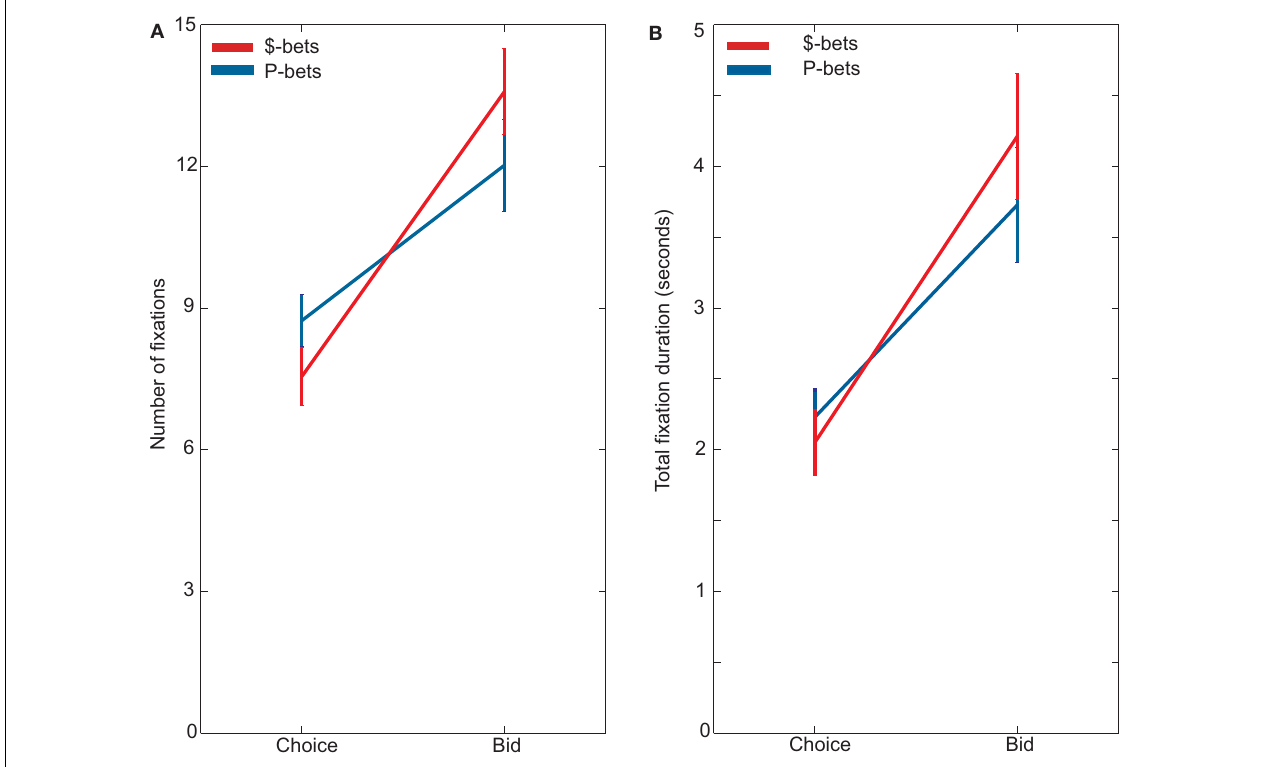
FIGURE 3 | (A) Average number of fixations of $-bets and P-bets during choices and bids. (B) Average duration looking at $-bets and P-bets during choices and